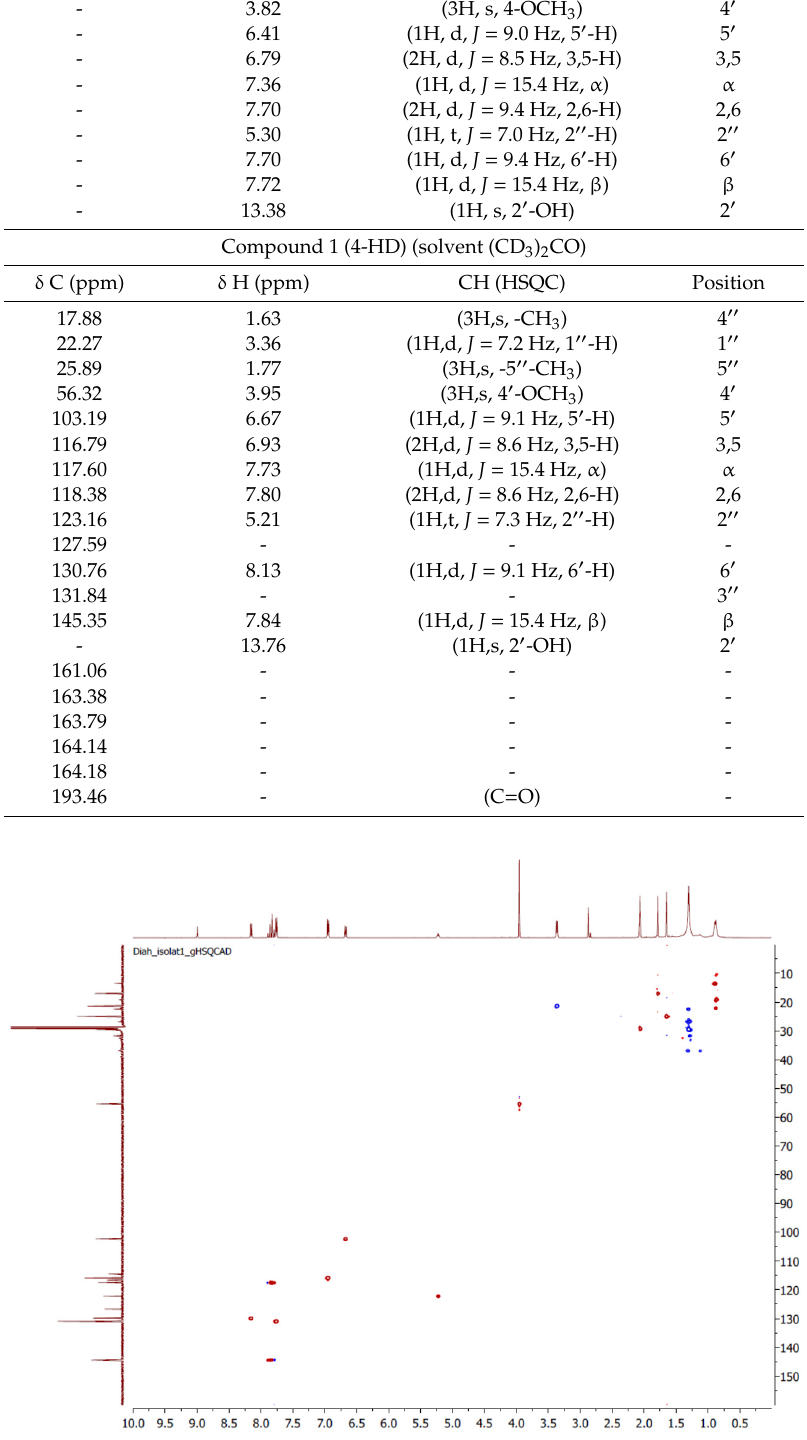
Figure 2. gHSQCAD spectrum of 4-hydroxyderricin (4-HD). Table 1. 1 H and 13 C NMR data of 4-hydroxyderricin from A. keiskei